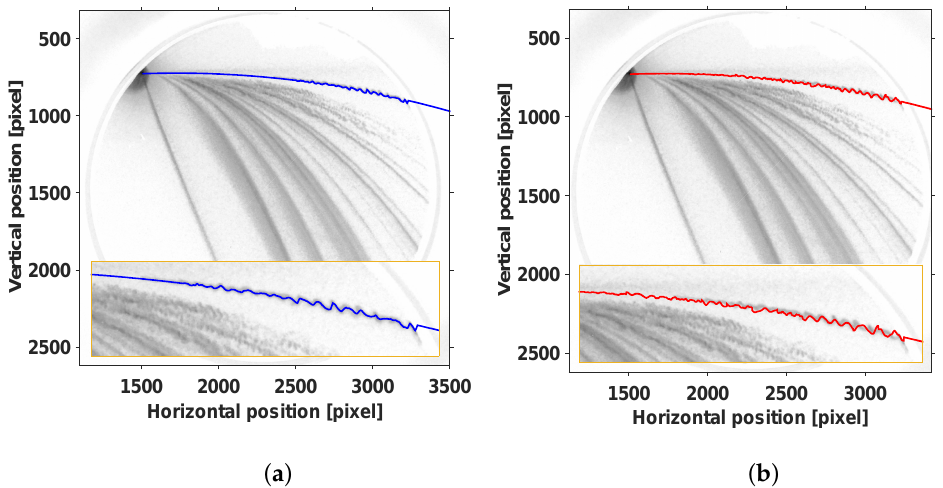
Figure 5. ( a ) Extracted parabolic track of protons as measured. ( b ) Modulated parabola plotted in MATLAB by introducing a varying electric field (3) into Equation